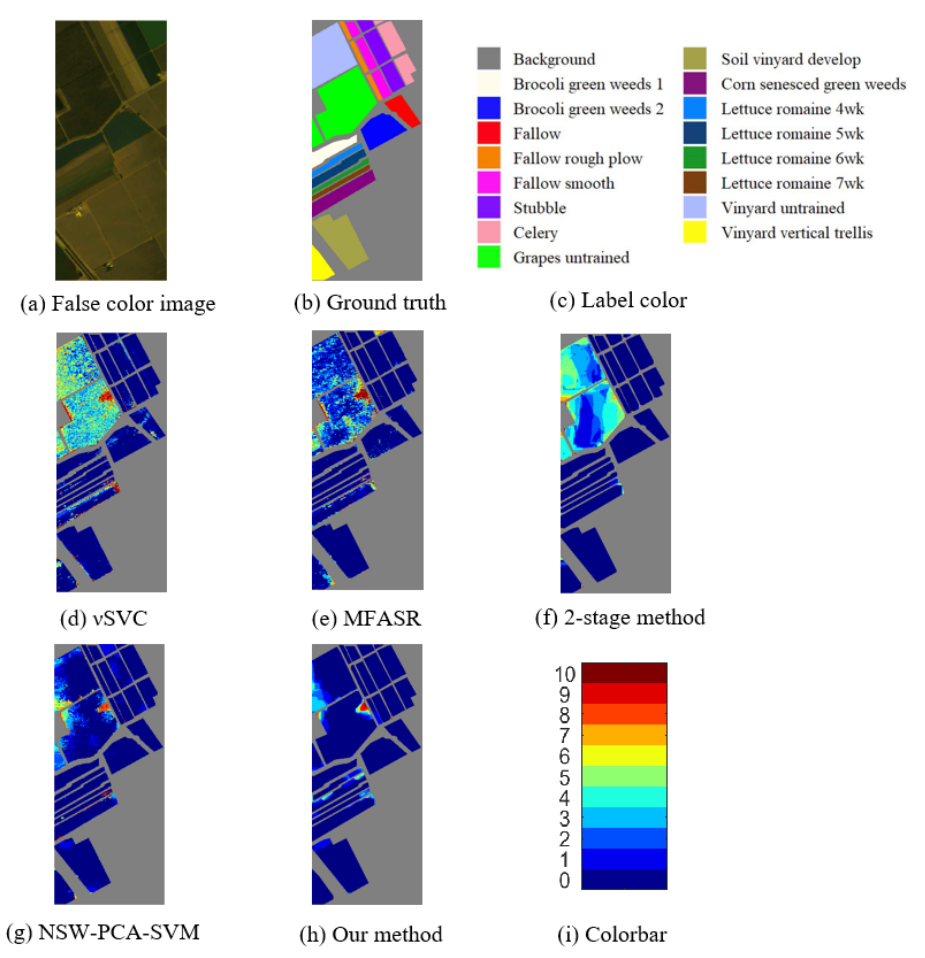
Figure 4. Results for the Salinas dataset. ( a ) The false color image. ( b , c ) The ground truth and corresponding label colors. ( d – h ) The misclassification counts of different methods. ( i ) The colorbar represents the misclassification